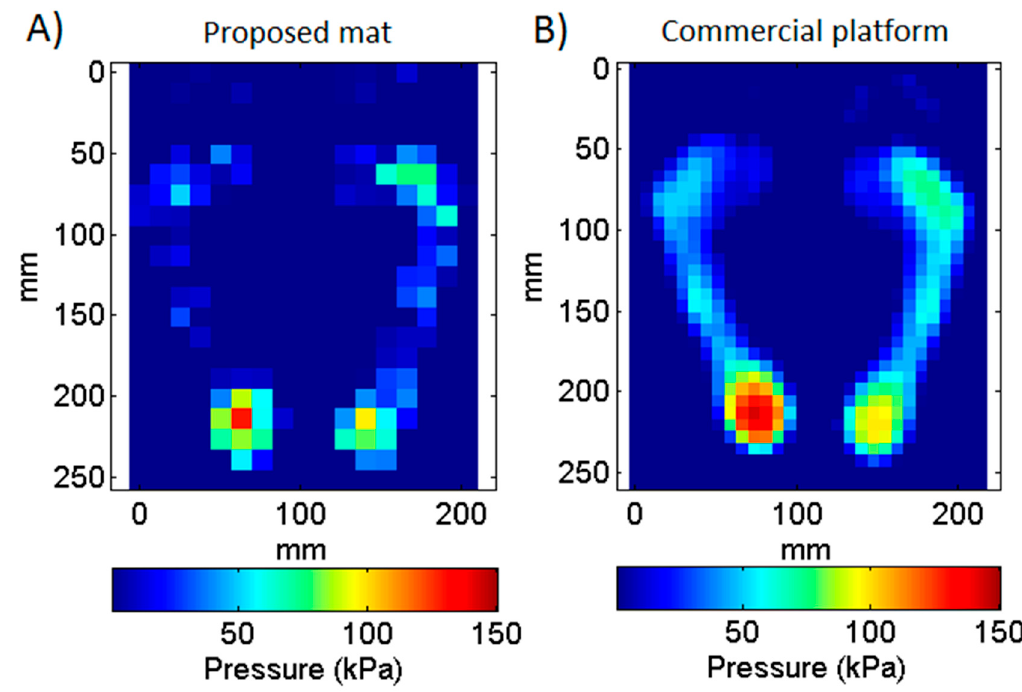
Figure 9. Comparison between two average plantar pressure maps acquired simultaneously with the proposed mat ( A ) and a commercial platform ( B ) during a bipedal standing trial. Maps represent the average pressure during a 30 s acquisition.